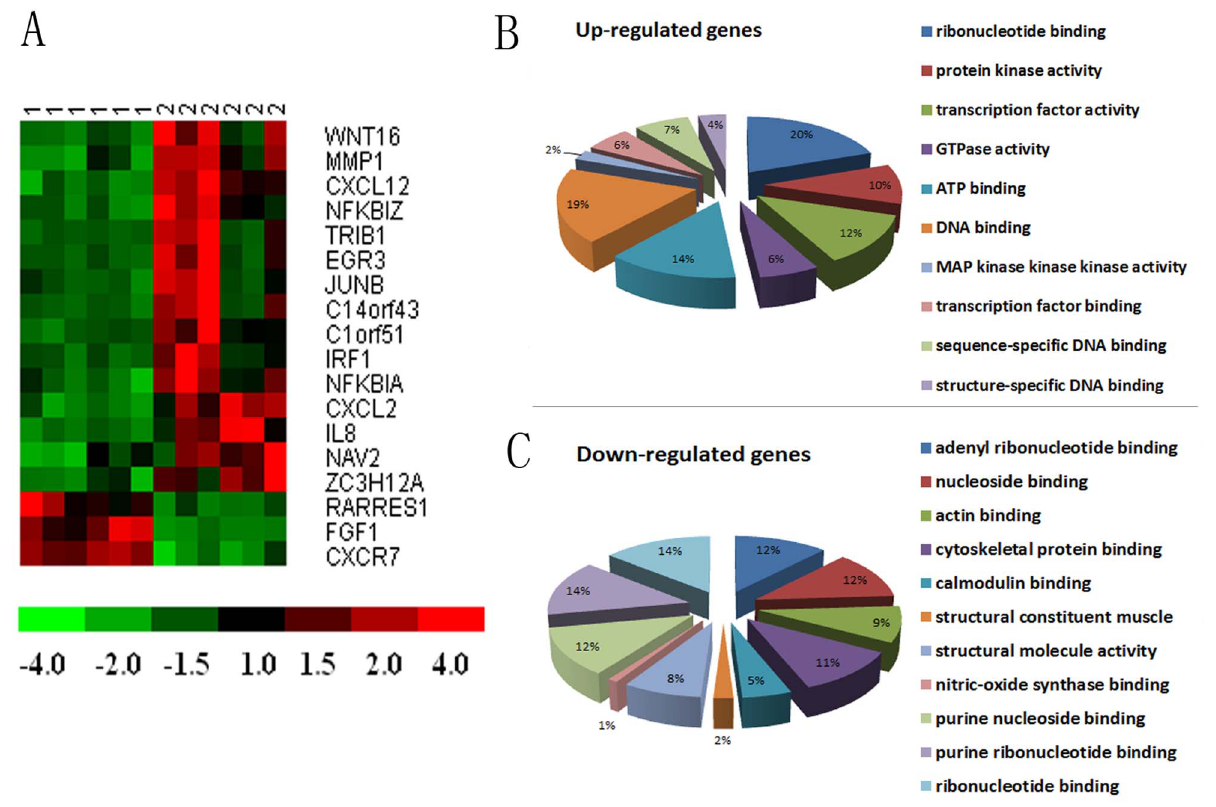
Figure 3. Hierarchical clustering of gene analysis expression and Gene Ontology (GO) analysis of CAFs before and after chemotherapy (treated with Taxotere). A showed the Heatmap plot of scaled gene-expression levels. The first 6 columns marked with ‘‘1’’ on top have represented the samples untreated with Taxotere, while the following 6 columns marked with ‘‘2’’ have represented the samples treated with Taxotere. Rows are genes with mean fold change between CAFs before and after chemotherapy. B and C revealed that these genes including up-regulated genes and down-regulated genes were mainly involved in nucleotide binding, actin binding, cytoskeletal protein binding and structural molecule activity through GO analysis.